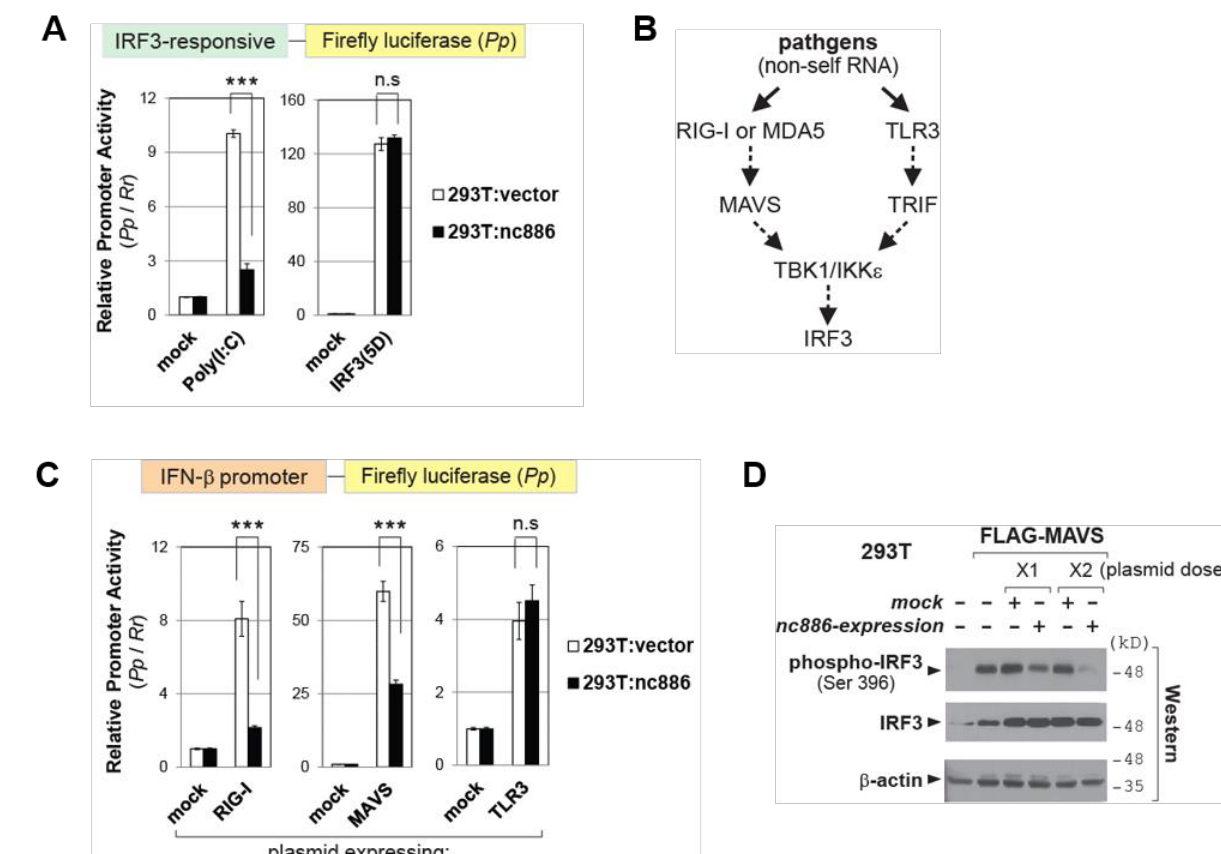
3 Figure 4. nc886 suppresses the IRF3 pathway. ( A ) Luciferase assays as described in Figure 3A, except that Poly(I:C)-LMW was used. ( B ) Simplified image for RIG-I and TLR3 pathways. Solid arrows designate pathogen sensing by indicated proteins; dotted arrows designate signal transduction between indicated proteins, which often involves multiple other factors. ( C ) Luciferase assays as described in panel A. ( D ) Western blot of indicated proteins at 24 h after transfection of MAVS-expressing plasmid in combination with control (“mock”) or nc886-expressing plasmid. Three asterisks designate a p -value less than 0.001. “n.s.”: not